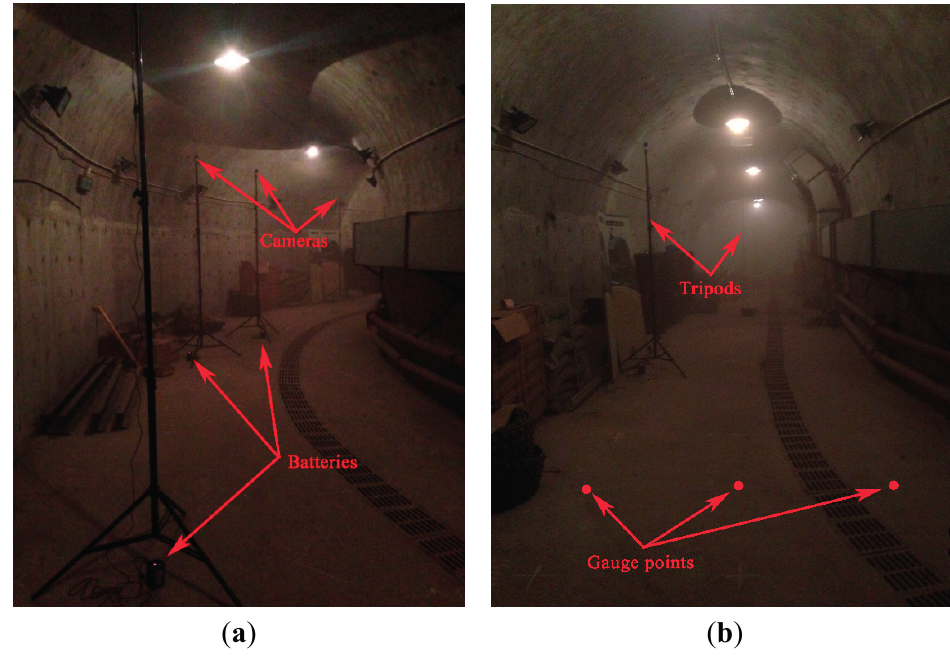
Figure 10. ( a )The actual deployment of cameras; ( b ) Gauge points on the ground of the